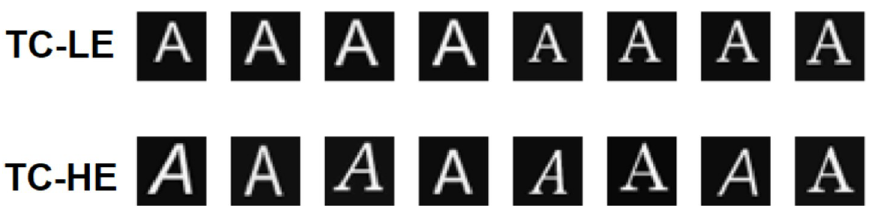
Fig 3. Samples of visual stimuli. Images from the low entropy dataset (TC-LE) contain letters printed using a limited number of variability factors, while images from the high entropy dataset (TC-HE) were created using a greater variety of fonts and